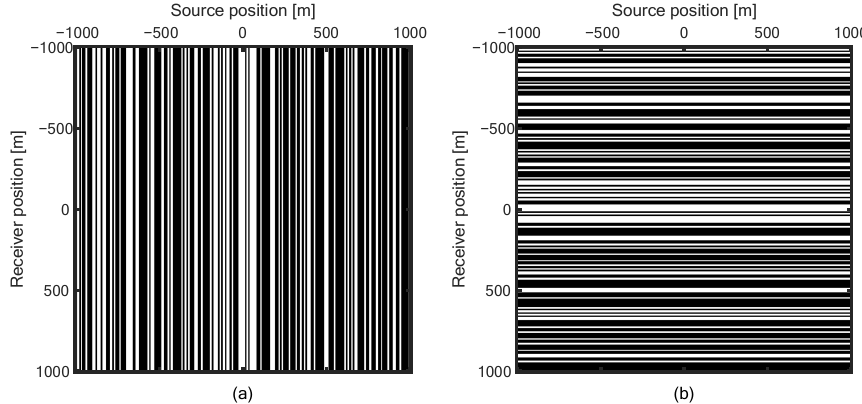
Φ (under the source dimension), and ( b ) is S